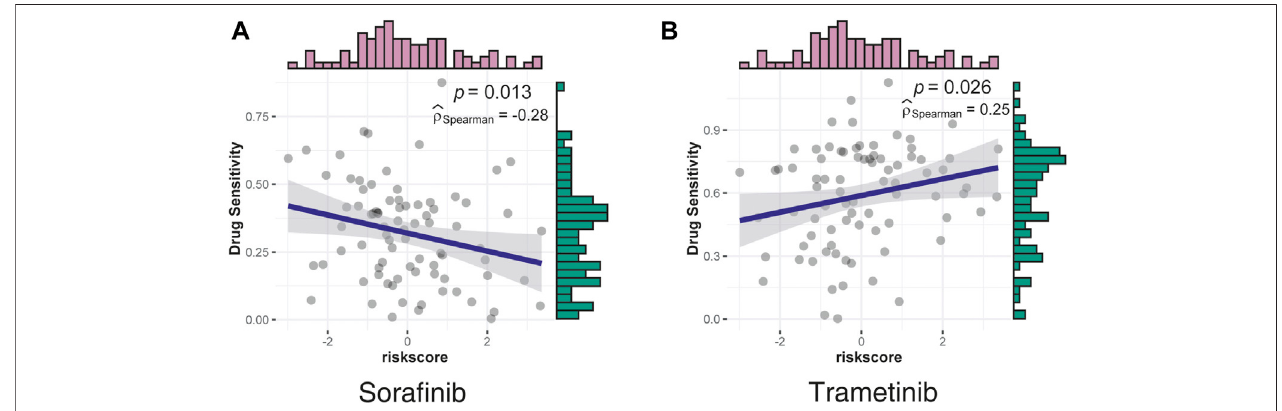
FIGURE 6 | Correlation between drug sensitivity and risk scores was assessed using data from LIMORE. (A) The sensitivity of sorafenib had a negative correlation with risk scores. (B) The sensitivity of trametinib had a positive correlation with risk